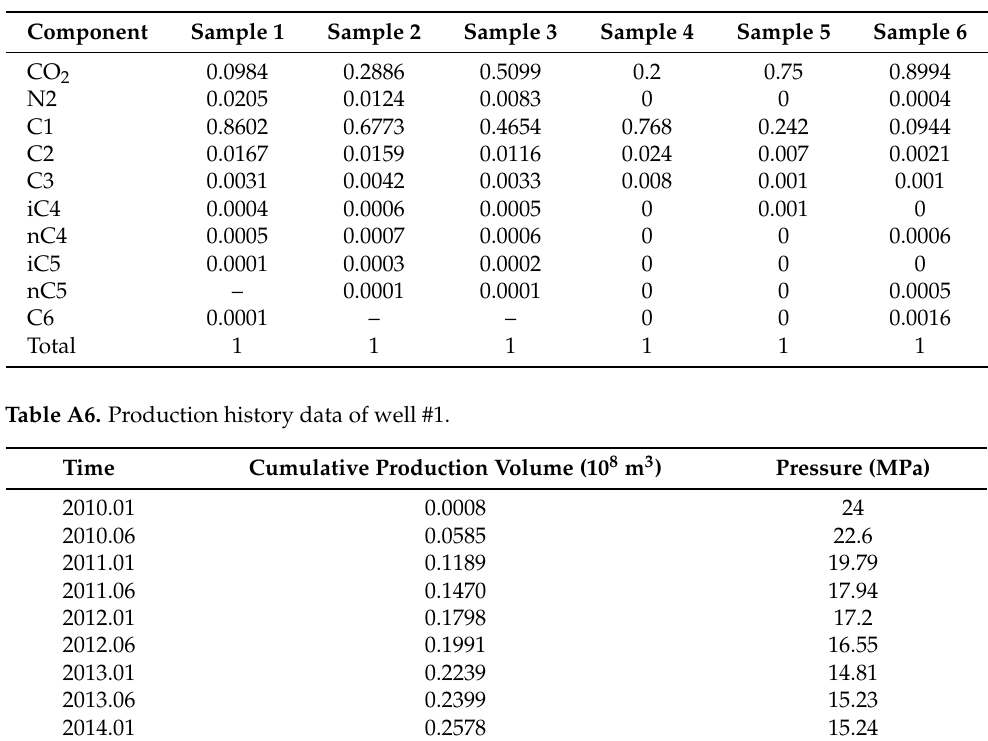
Table A5. Compositions of the six natural gas mixtures from the literature to validate the four empirical correlations, where samples 1–3 are taken from Bian et al. [7] and samples 4–6 are from